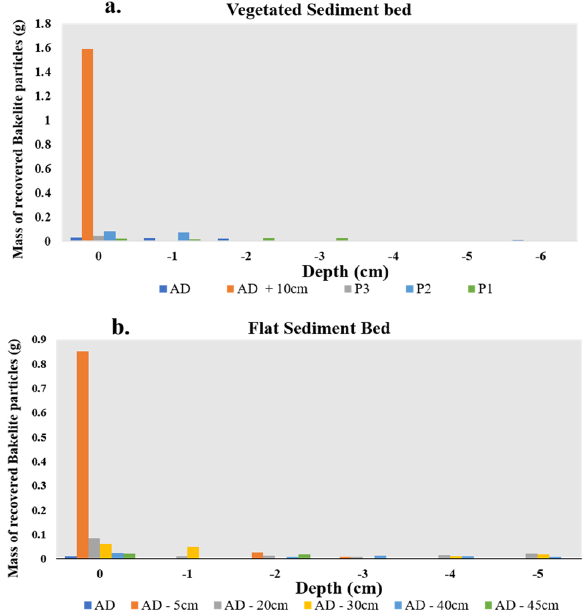
Figure 7. Mass of recovered Bakelite particles from post-experiment cores and their depths (in cm) for ( a ) vegetated sediment bed (Test A) and ( b ) flat sediment bed (Test C). AD means Area of Deployment; the negative sign means upstream (against the water flow direction) and positive sign means downstream (in the direction of the water